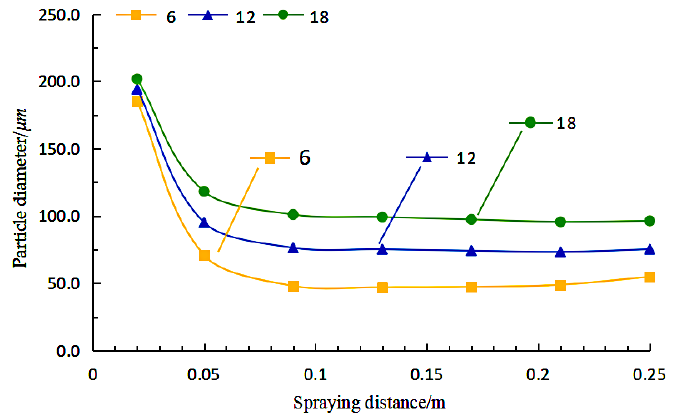
Figure 13. Variation of particle diameter with spraying distance for different critical Weber num- bers.